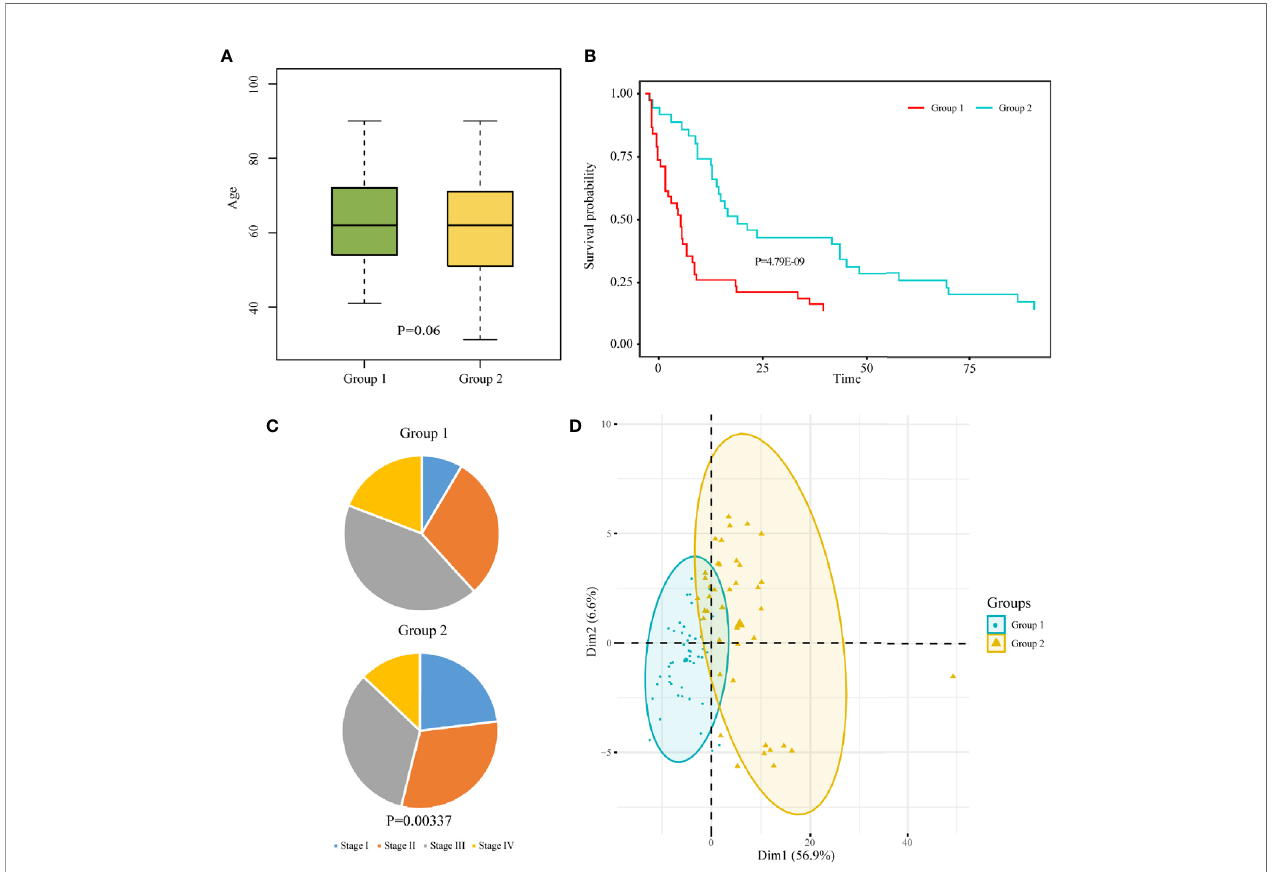
FIGURE 4 | Clinicopathological characteristics between two subgroups of rectal cancer. Box chart of age (A) , pathological stage pie chart (B) , and survival curve (C) between the two subgroups of READ. (D) Principal component analysis of the two